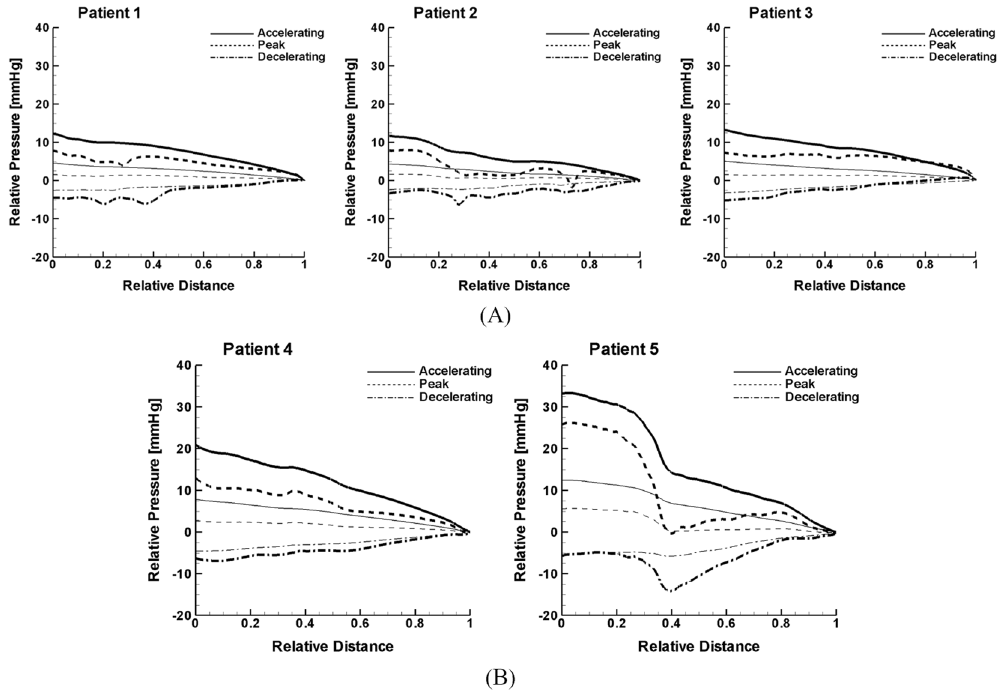
Figure 6. Pressure distribution with a cardiac cycle from accelerating or 0.25T sys (solid lines) to peak or 0.5T sys (dashed lines) and decelerating or 0.75T sys (dashed dot lines) stage along the aorta center line relative to the descending aorta outlet as shown in Fig. 1C under the normal and AF flow condition in ( A ) patient 1, 2, and 3 and ( B ) patient 4 and 5. Thick and thin line denote the normal and AF flow condition, respectively. T sys denotes the systolic period of a cardiac